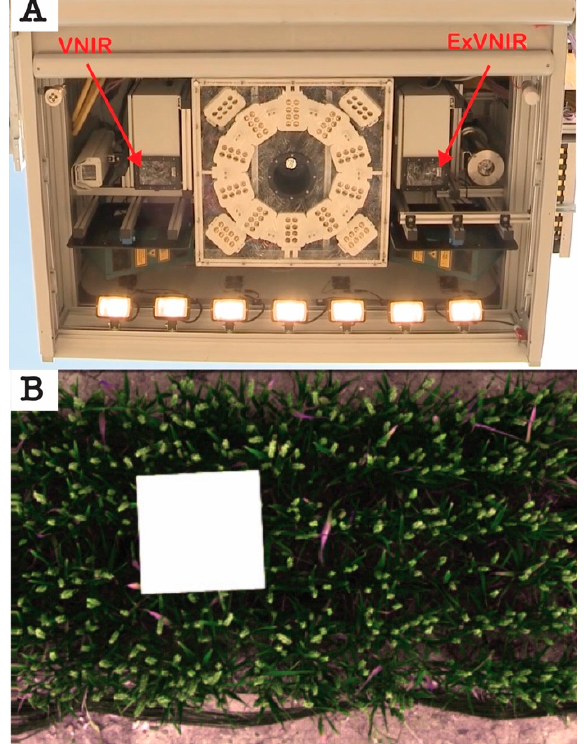
Figure 1. ( A ) Camera bay of the Field Scanalyzer accommodating the VNIR sensor ( B ) The white referencing Ultra-lightweight Reflectance Target in pseudo-RGB (R:620 nm, G:535 nm, B:445 nm).